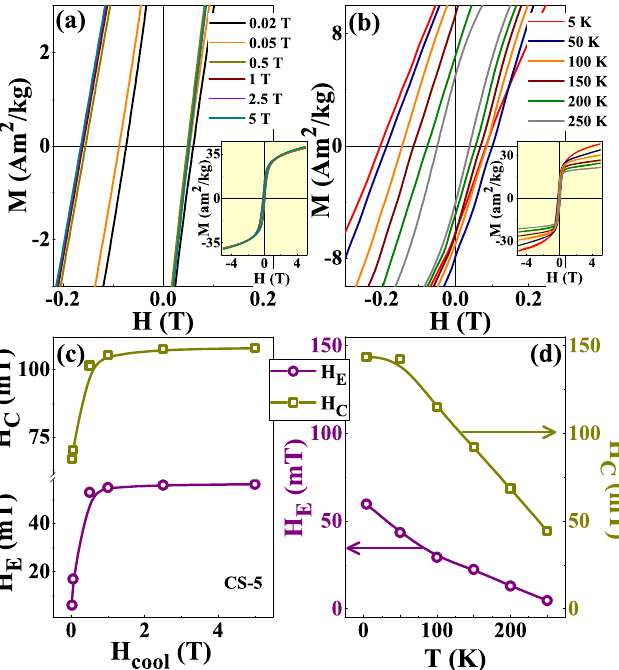
Figure 7. ( a ) Low field region of M − H loops of CS-5 recorded at 4 K in between ± 5 T for H cool = 0.02, 0.05, 0.5, 1, 2.5 and 5 T. Inset of ( a ) shows the corresponding M − H loops in full scale. ( b ) M − H loops of CS-5 measured at different temperatures in FC mode at H cool = 1 T. Inset of ( b ) shows the corresponding M − H loops in full scale. ( c , d ) Variation of H E and H C with change in cooling field and temperature,